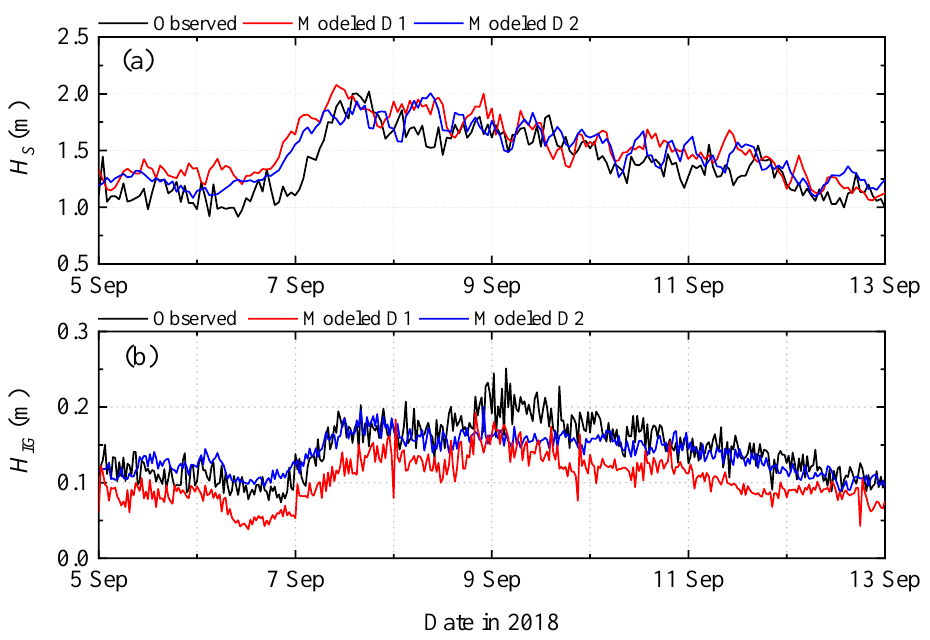
Figure 5. Significant wave heights modeled by D1 and D2, 5–13 September 2018, at the location of sensor G1. ( a ) Significant short wave height H S and ( b ) significant IG wave height H IG Table 3. Performance statistics for D1 and D2. Computational Domain CC RBIAS NRMSE